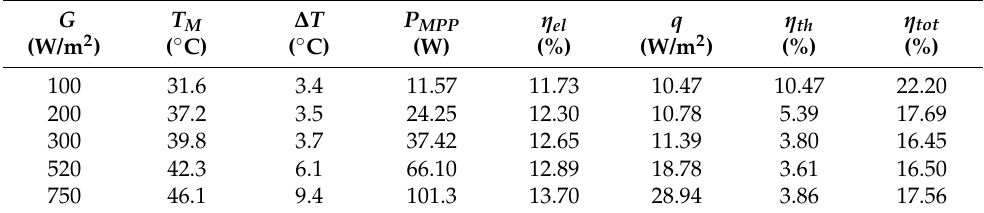
(cid:3119) . (cid:2918) . V = 9.12 m 3 . h